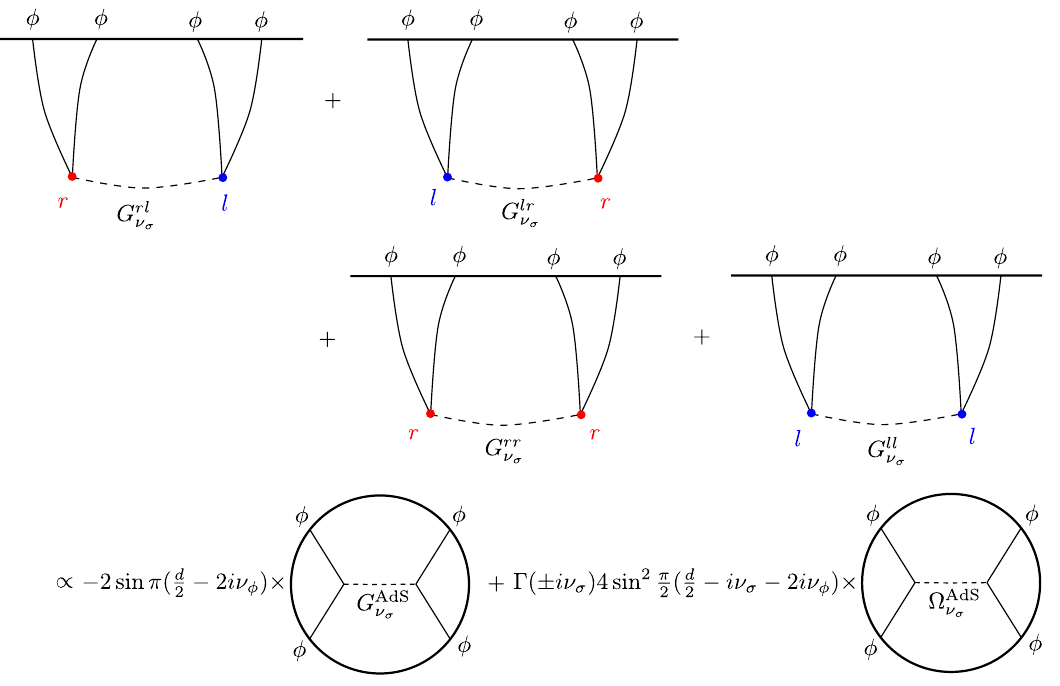
Figure 16 . Exchange diagram in dS. There are four contributions, because each of the two vertices can be on the left or the right portion of the in-in contour. Relating each dS propagator to a combination of EAdS propagators and harmonic functions, the full exchange diagram in dS becomes proportional to the linear combination of EAdS diagrams in the last line, with some oscillatory dimension-dependent factors. One can then readily obtain the conformal partial wave decomposition in eq.